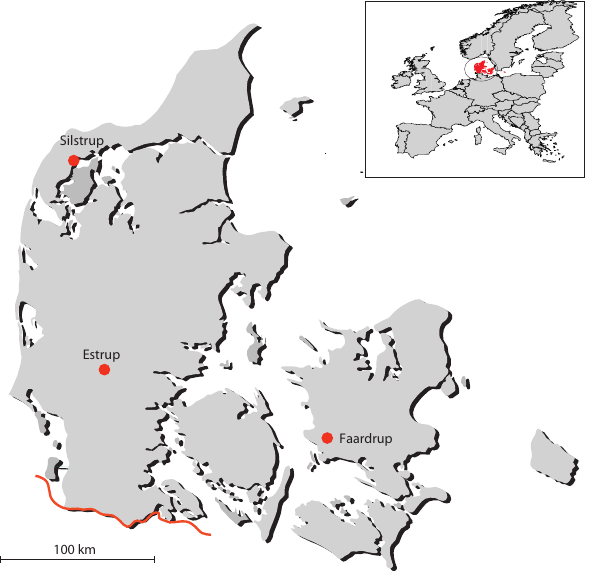
Figure 1. Map of Denmark showing the three clayey till fields: Faardrup, Silstrup and Estrup (Lindhardt et al.,